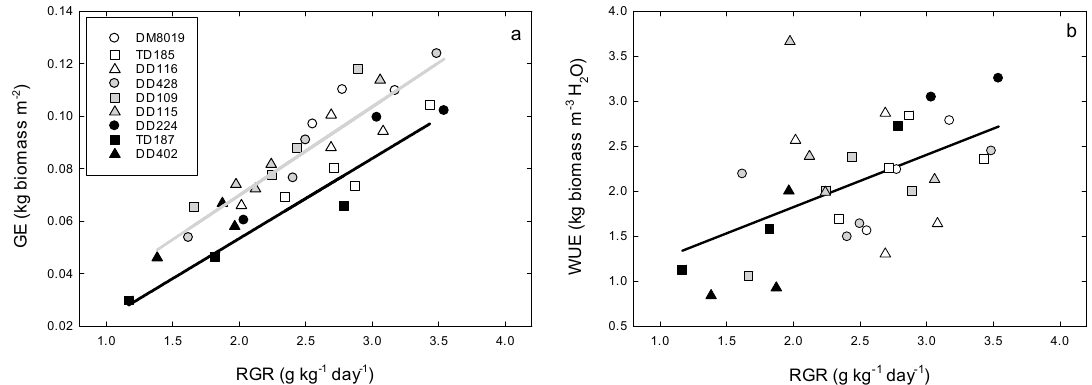
Figure 2. Relationships between ( a ) stem growth efficiency (GE) and ( b ) water use efficiency of production (WUEp) and average relative growth rate (RGR) of biomass growth over the 146 day study period in P. deltoides (DD), P. trichocarpa x deltoides (TD), and P. deltoides x maximowiczii (DM) clones. Open, light shaded, and dark shade symbols represent high (Group H), intermediate (Group I), and low (Group L) productivity genotypes, respectively. In panel a, the grey line is the regression for DM and DD clones and the black is for TD clones.